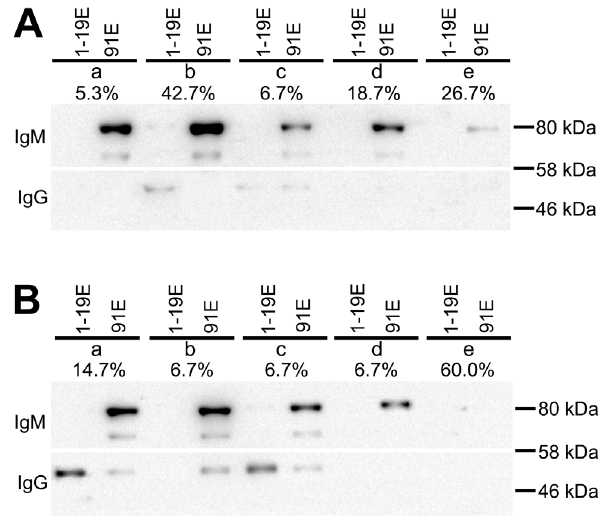
Figure 3. Western blot for IgG and IgM eluted from H3 1 – 19 and H3 1 – 19 K9me beads. Equal volumes (1.5 ml) of pooled sera were first absorbed with the H3 1–19 beads and then with the H3 1–19 K9me beads as described in the Materials and Methods. The beads were washed 5 times with 1 M NaCl, and the bound Abs were eluted with 50 m l elution buffer. 10 m l of the eluates underwent SDS-PAGE under reducing conditions and were then transferred onto nitrocellulose membranes. The membranes were cut at the 58 kDa position. IgG on the low molecular weight ( , 58 kDa) membrane and IgM on the high molecular weight ( . 58 kDa) membrane were detected. (A) Healthy adult samples; (B) aSLE patient samples. a, IgG(1–19 high 91 x )IgM(1–19 x 91 x ); b,